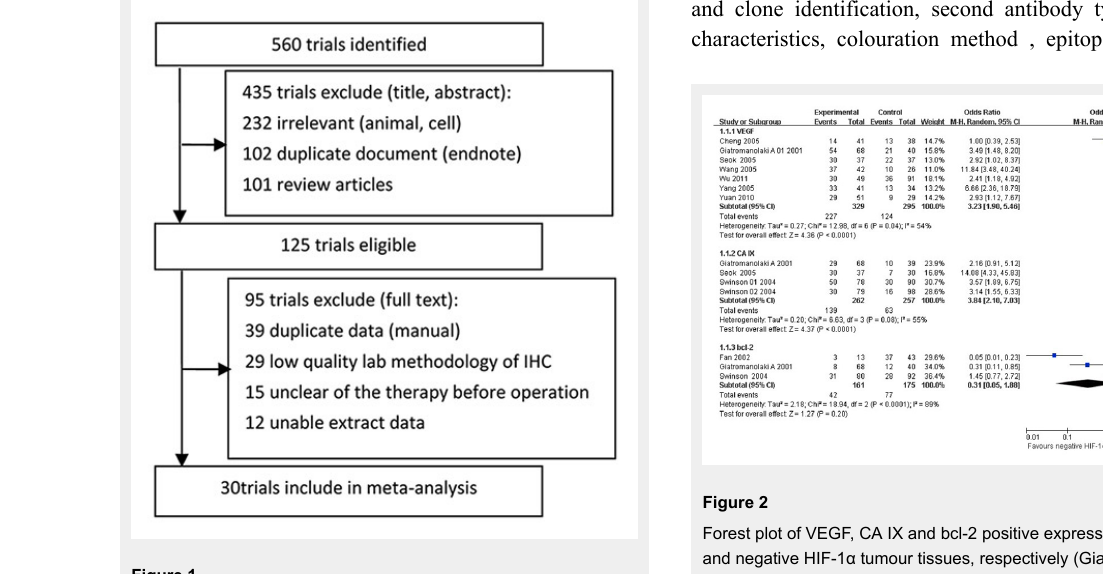
Flow chart of article selection in the systematic review and meta- analysis.